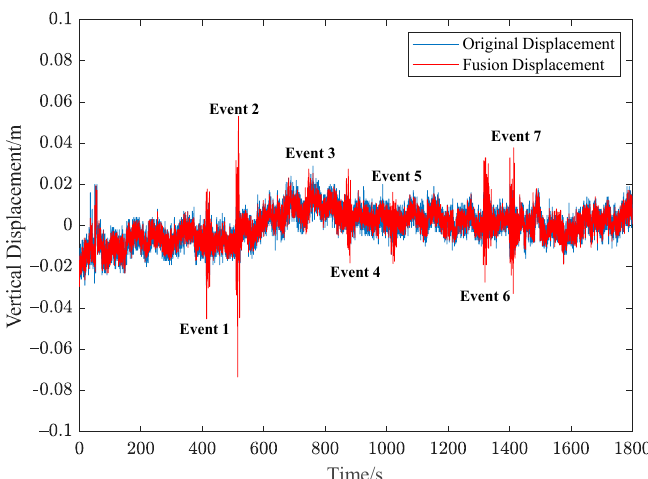
Figure 11. Wilford Bridge vertical displacement before and after GNSS/accelerometer fusion.